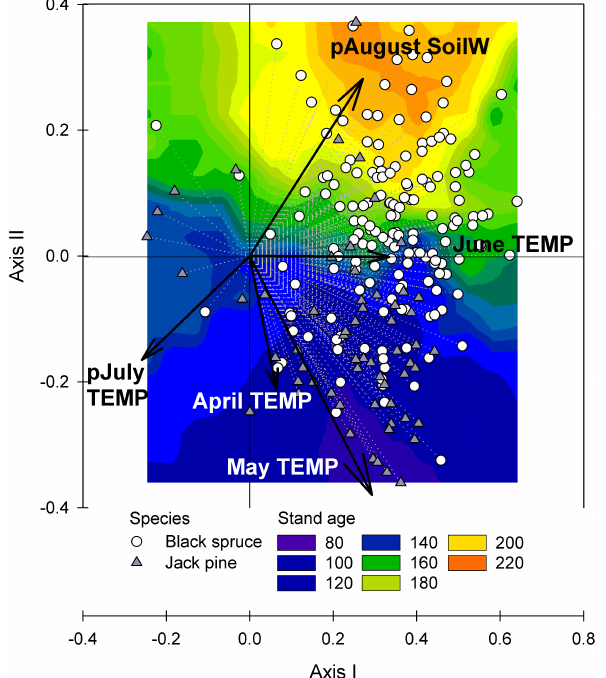
Fig. 4. Means of (a) black spruce and (b) jack pine plot-level TGI time series computed over 1900 to 2005 with 90% confidence inter- vals. Black spruce plot-level TGI time series were pooled accord- ing to their position along axis II of the RDA ordination diagram (Fig. 3), with “mature” gathering all plot-level TGI time series with axis II loading from –0.40 to –0.05, “transition” gathering those with loading from –0.05 to 0.05, and “overmature” gathering those between 0.05 and